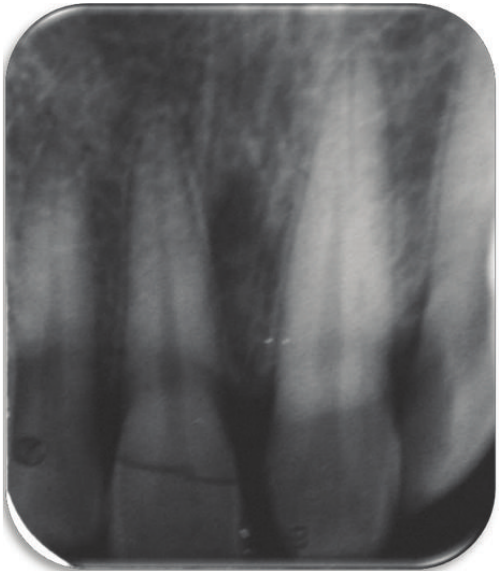
Figure 2: Preoperative radiograph.